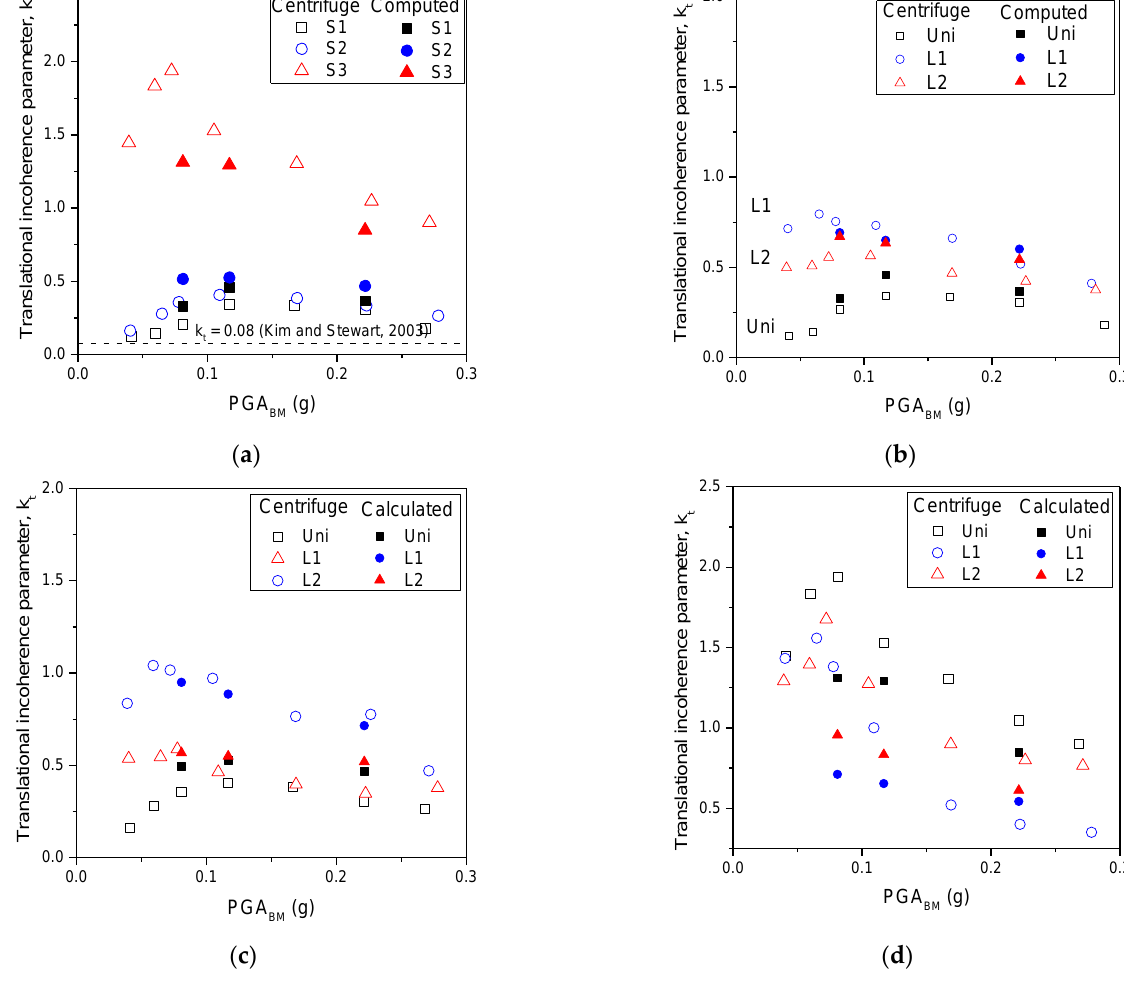
Figure 10. Translational incoherence parameters defined for ( a ) three structures on Uni profile, ( b ) S1 structure on three profiles, ( c ) S2 structure on three profiles, and ( d ) S3 structure on three profiles.